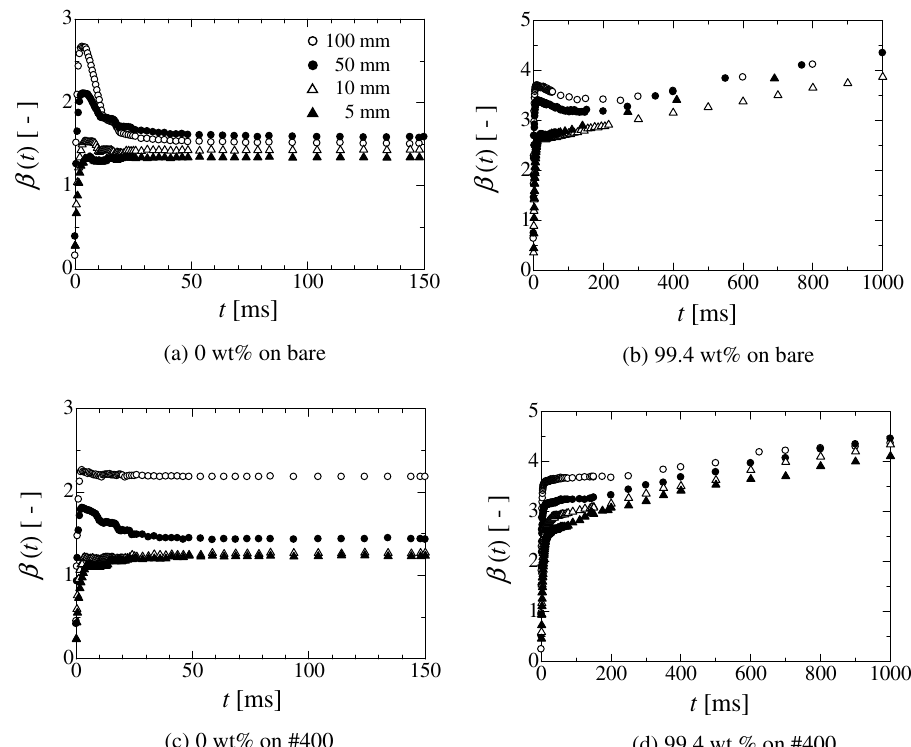
Figure 1. Time evolution of normalised contact-area diameter β ( t ) (= d cont ( t )/ d 0 : d cont the contact-area diameter, d 0 the initial droplet diameter). The symbols of solid triangle, open triangle, open circle and solid circle represent the release heights of the droplet from 5, 10, 50 and 100 mm, respectively. The droplet is released from each height with no initial